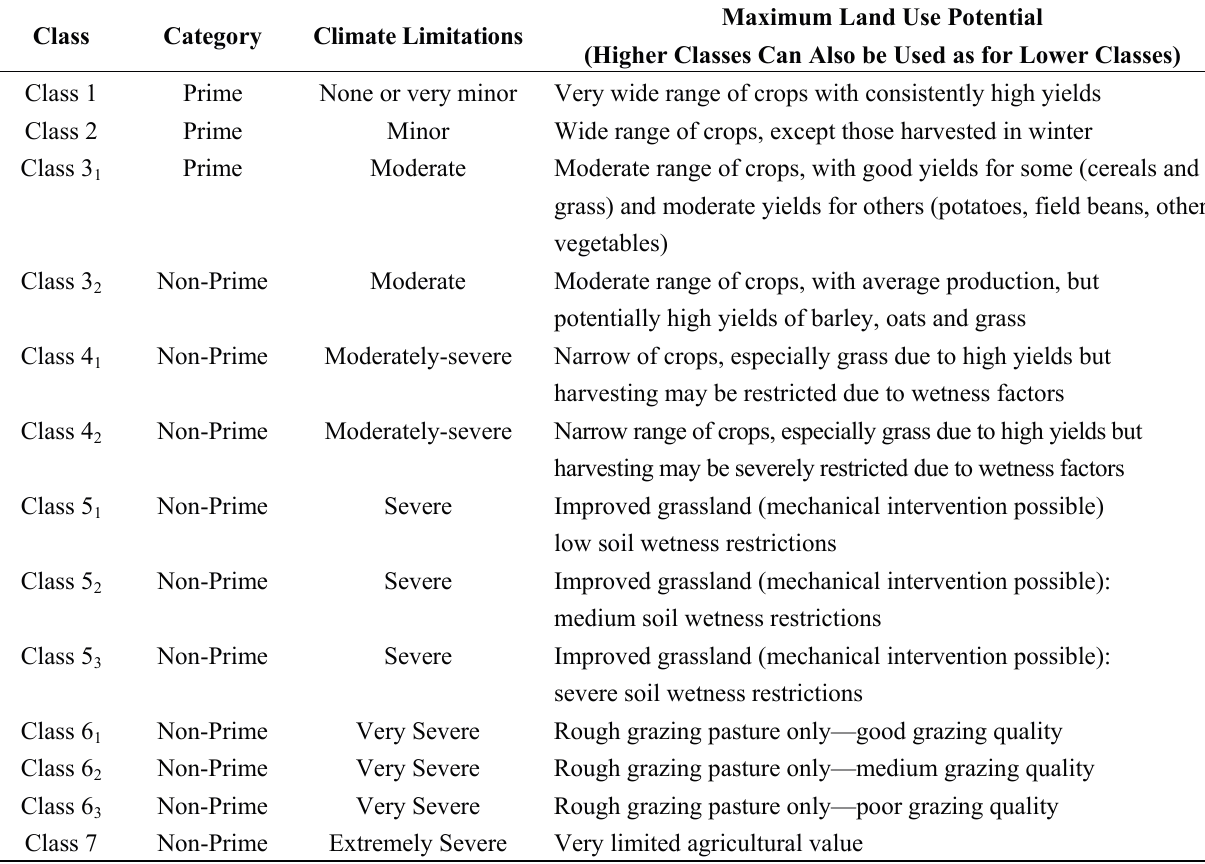
Table 1. Land Capability for Agriculture (LCA) classes for Scotland and associated land use